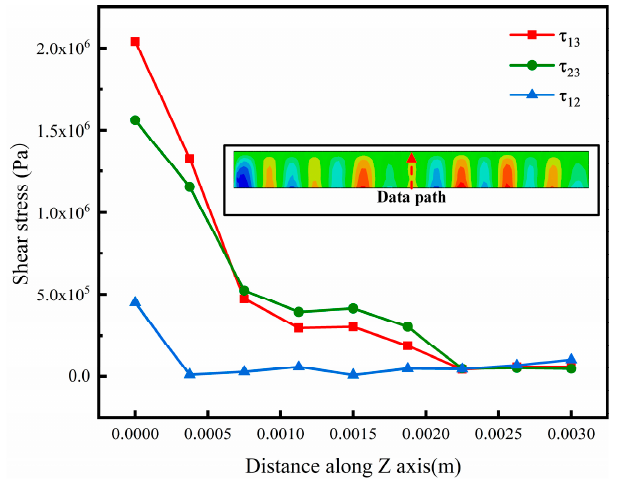
Figure 15. Average shear stress amplitude varies along the Z axis.